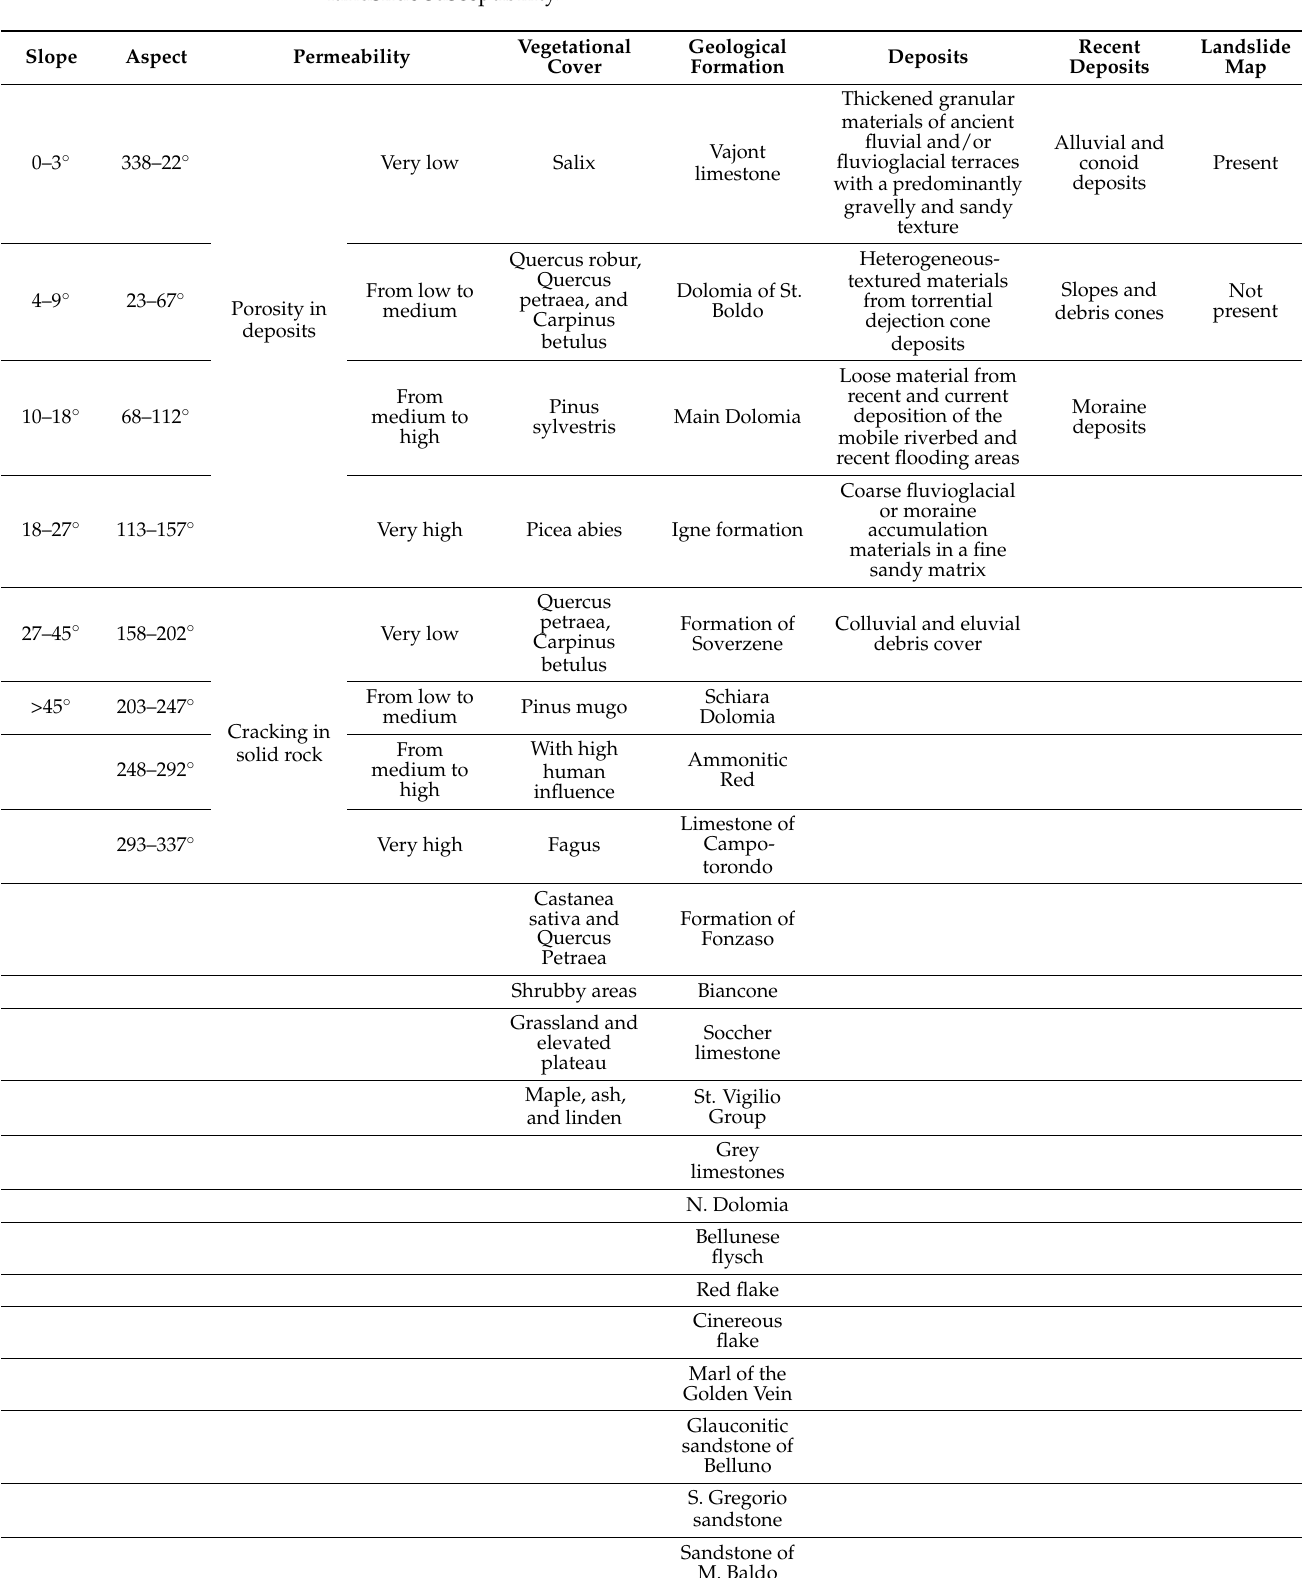
Table 1. Geomorphological and environmental parameters divided into classes for the assessment of landslide